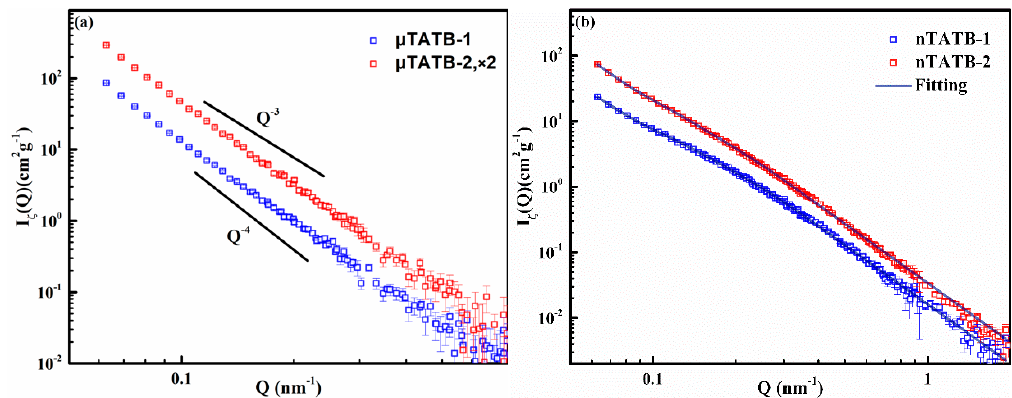
Figure 6. ( a ) Internal structure functions of micro-sized TATB samples. ( b ) Internal structure functions of nano-sized TATB samples, and the solid lines are the fitting results according to Equation (3).